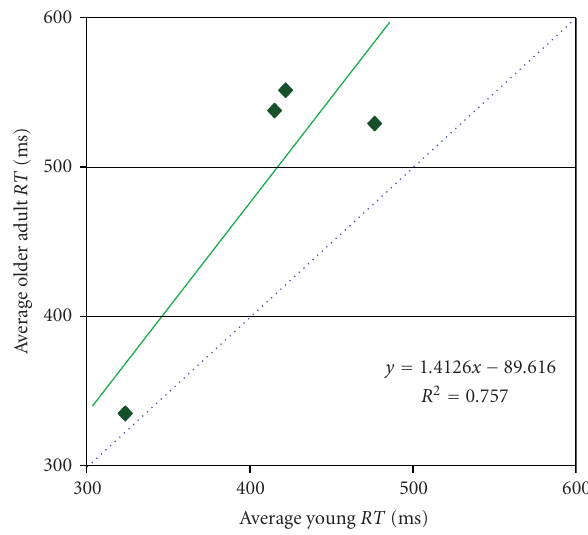
Figure 2: Traditional Brinley plot of response times for the 4 tasks used in the fMRI meta-analysis. If young and older adults showed equivalent between-task change in the speed of responses across these studies, the slope of the fitted line would be 1 (dotted blue line); however, results indicated that some general cognitive slow- ing is evident within the datasets since the slope of the fitted line was 1.4 (solid green line).